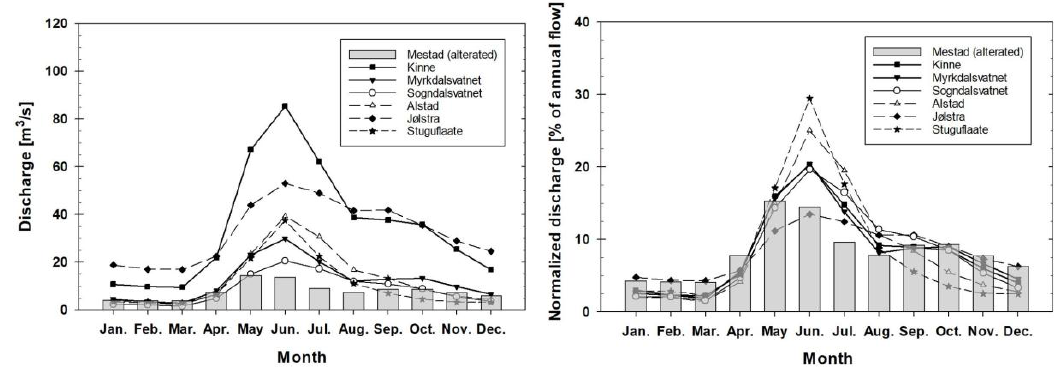
Figure 3. Absolute ( left ) and normalized ( right ) mean monthly discharges of the kayaking gauges. From NVE-database, time series 1986–2015.